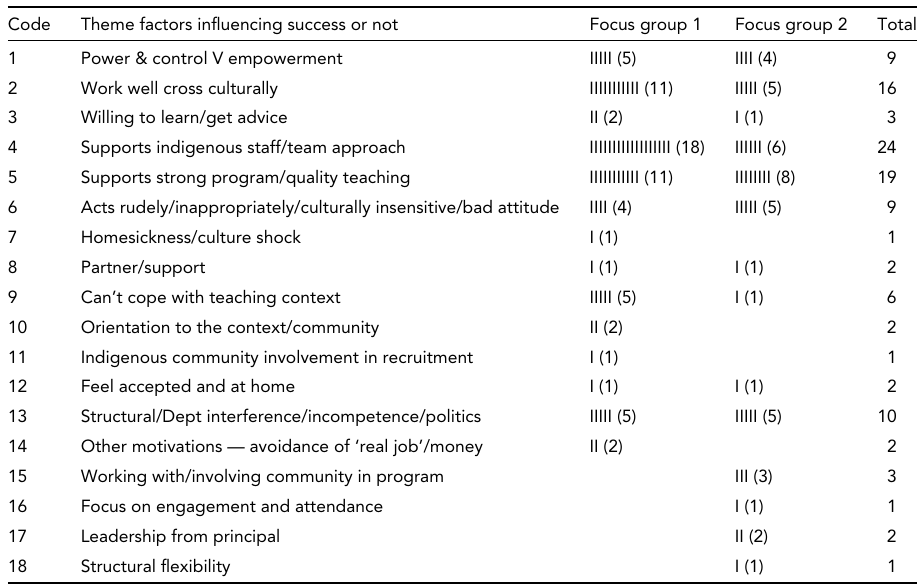
Indigenous Focus Group research: